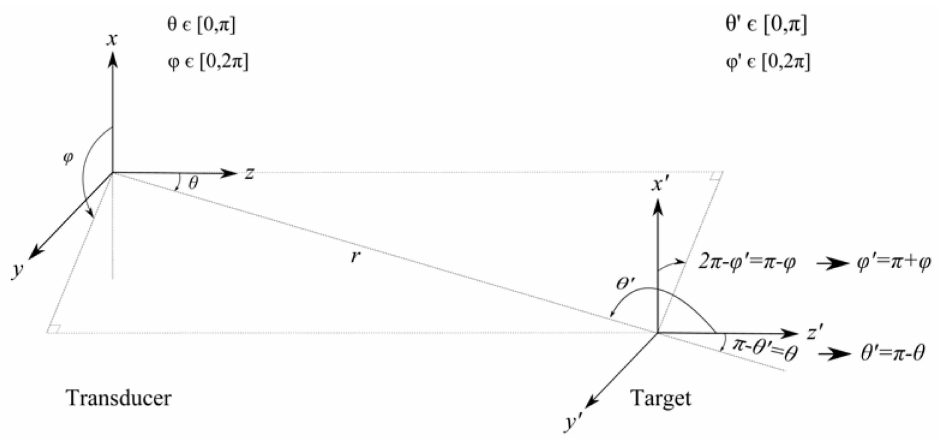
Figure 2. Sketch of an arbitrary transducer: target positions giving the relationship between ( θ , φ ) and ( θ (cid:48) , φ (cid:48) ) for backscattering from a single target at arbitrary location ( r , θ , φ ) . The backscattering direction is given as θ (cid:48) = π − θ , φ (cid:48) = π + φ . (Reproduced from [22], with permission from the Institute of Marine Research,